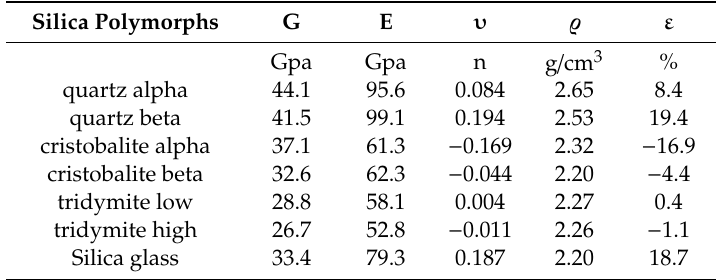
Figure 13. Scheme of propagation of fractures in quartz granules; ( A ) beginning of the phenomenon, as the fractures spread; ( B ) formation of fractures ending with the euhedral craters and superficial “elevations”; ( C ) formation of craters (“hot spots”) and the protrusion of silica from the molten areas below. Table 1. Mechanical parameters for silica polymorphs [13,14,20], G = Shear modulus, E = Young modulus, n = Poisson ratio, ρ = density, ε = strain.